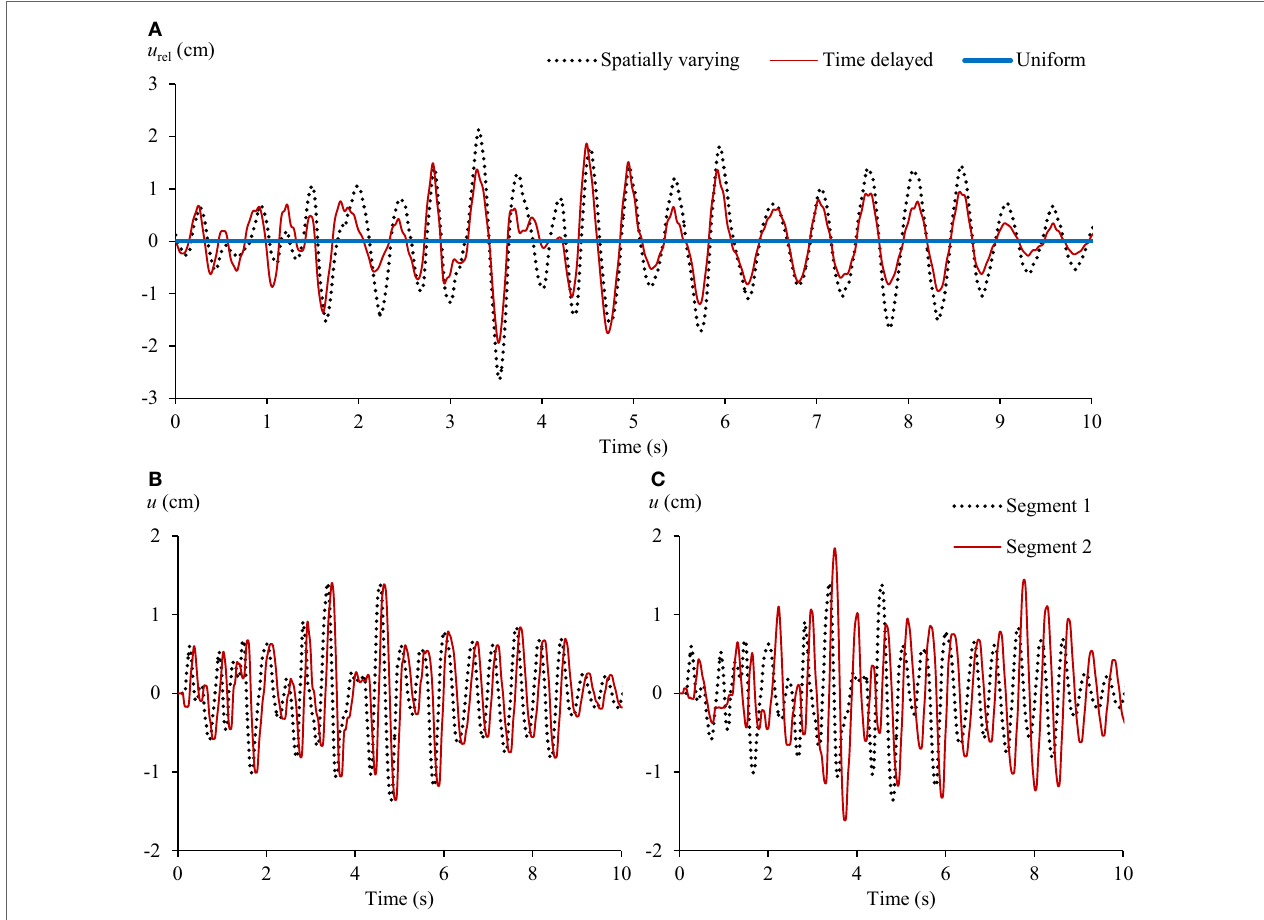
FigUre 7 | Time histories of (a) the relative displacements between segments 1 and 2, the absolute displacements of segments 1 and 2 due to (B) time delayed excitations and (c) spatially varying excitation with ssi